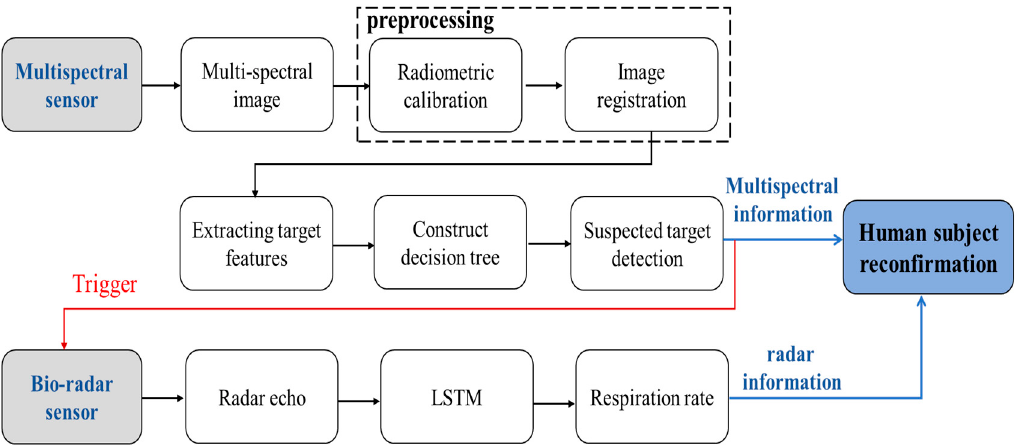
Figure 5. The flowchart of bimodal-information-based human targets recognition method.